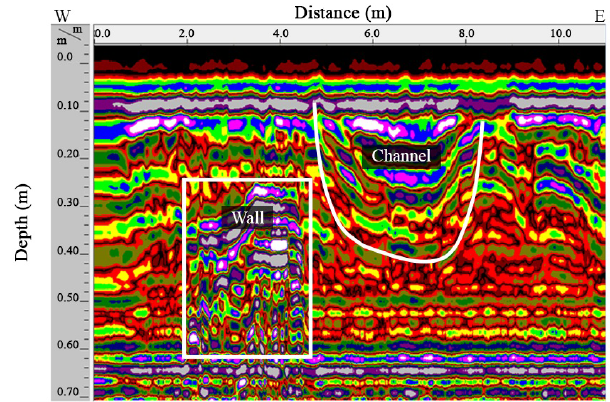
Figure 9. The 3D GPR data view constructed from 2D profile lines. The 3D perspective view of processed profiles using high pass and low pass vertical and horizontal filters together with migration tech- nique that show the location of the pottery